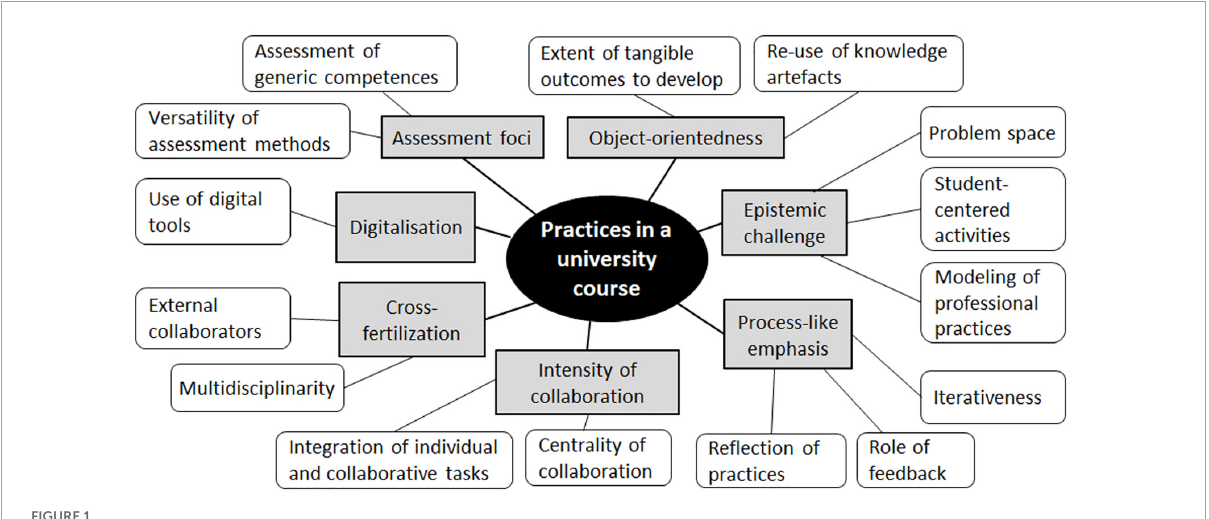
FIGURE1 Overview of categories of pedagogical